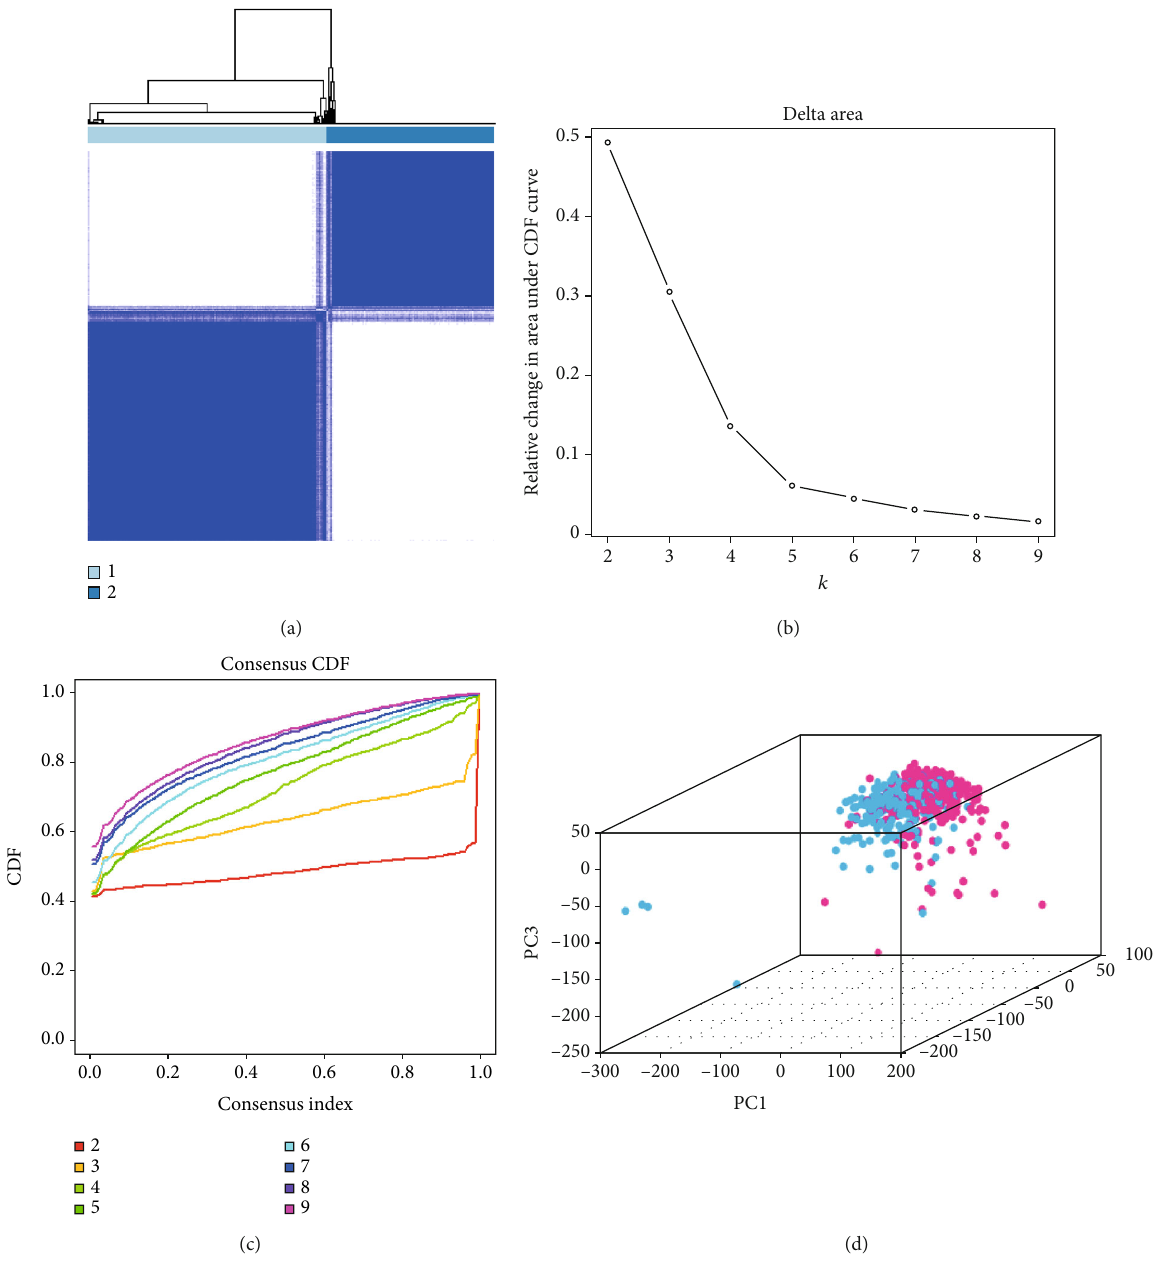
Figure 2: Identi fi cation of consensus clusters by m 6 A RNA methylation regulators. (a) When k = 2 : correlation between groups. (b) Relative change in the area under the cumulative distribution function (CDF) curve for k values from 2 to 9. (c) Consensus clustering CDF when k value ranges from 2 to 9. (d) Principal component analysis of the total RNA expression pro fi le in the TCGA dataset (cluster 1 is marked in red and cluster 2 in